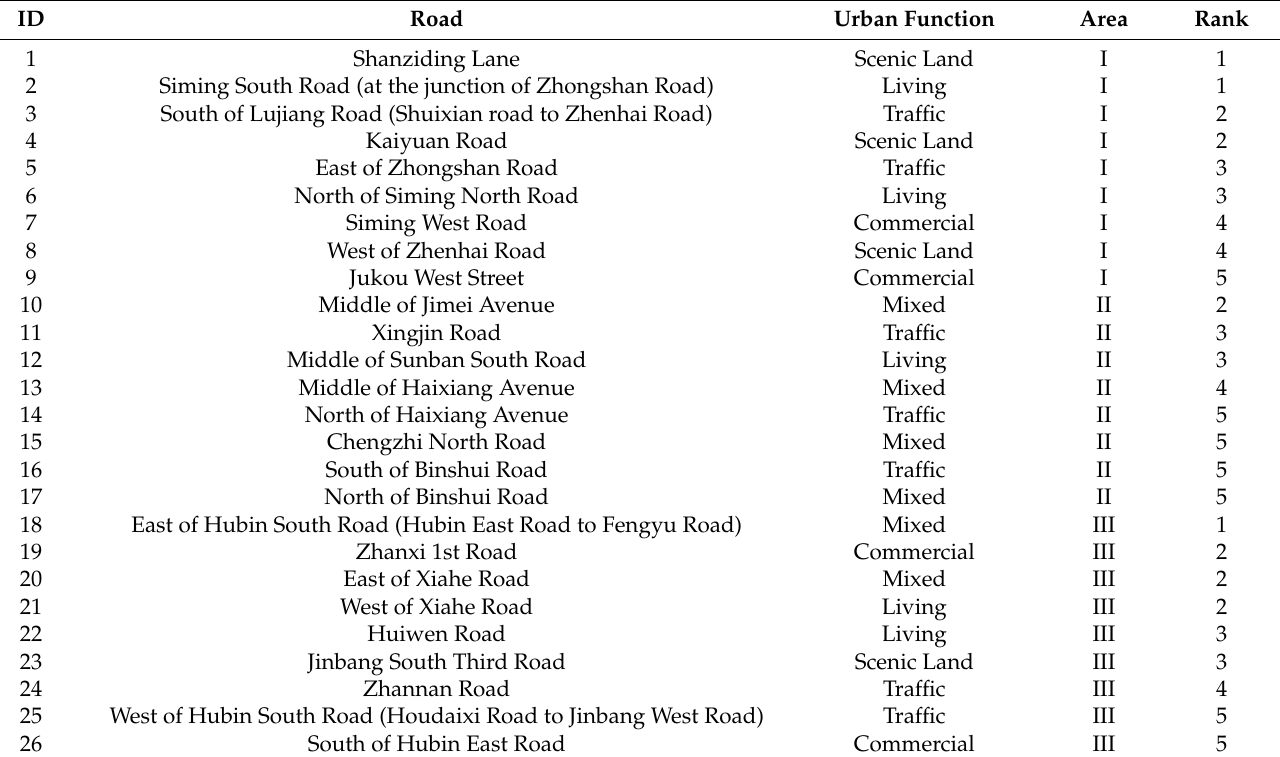
Figure 14. Street quality assessment results of ( a ) Area I, ( b ) Area II, and ( c ) Area III. Table 4. Street quality assessment results of some